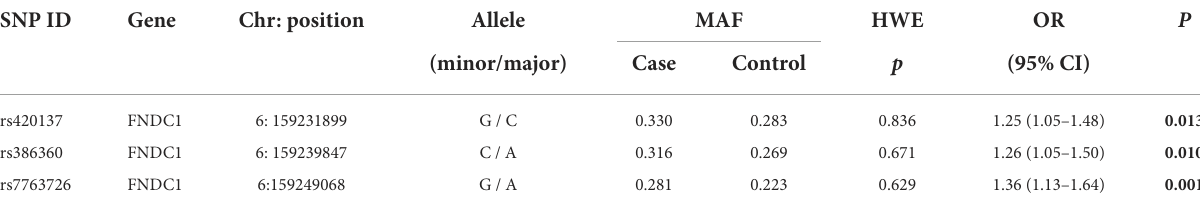
TABLE 3 Genotypes frequencies distribution and association with CHD risk.